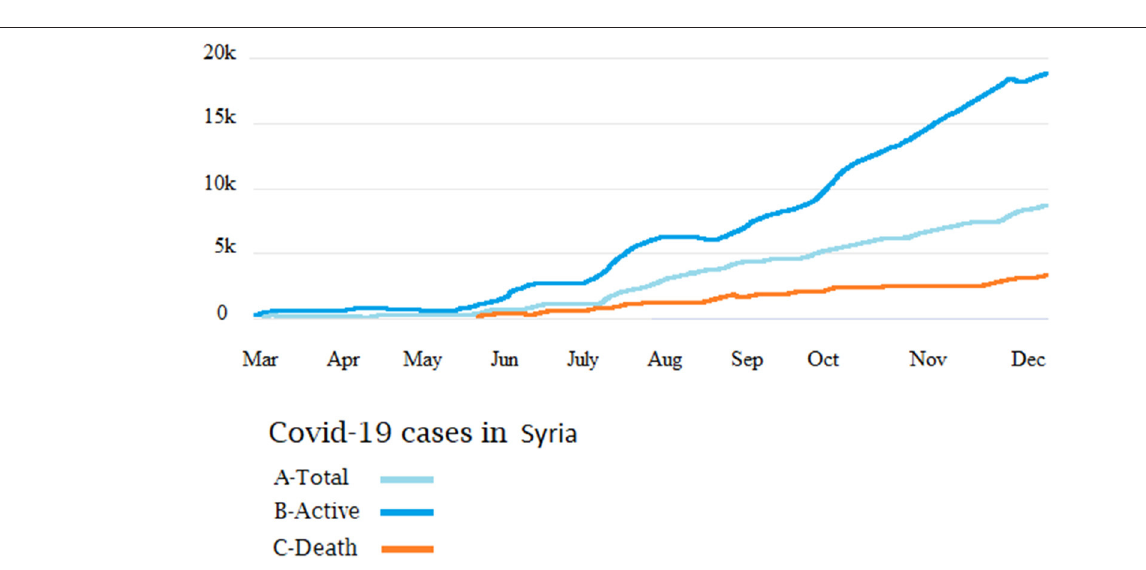
FIGURE 6 | The number of officially reported cases of COVID-19 in Syria. Cumulative cases (A) , recoveries (B) , and number of deaths (C)